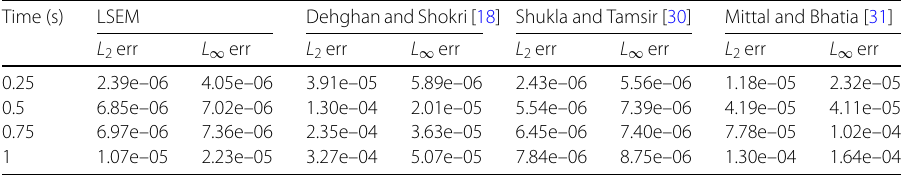
Table 3 Comparison of L 2 err and L ∞ err of Example 5.2 with N = 7, N e = 30, and k = 0.001 at different time